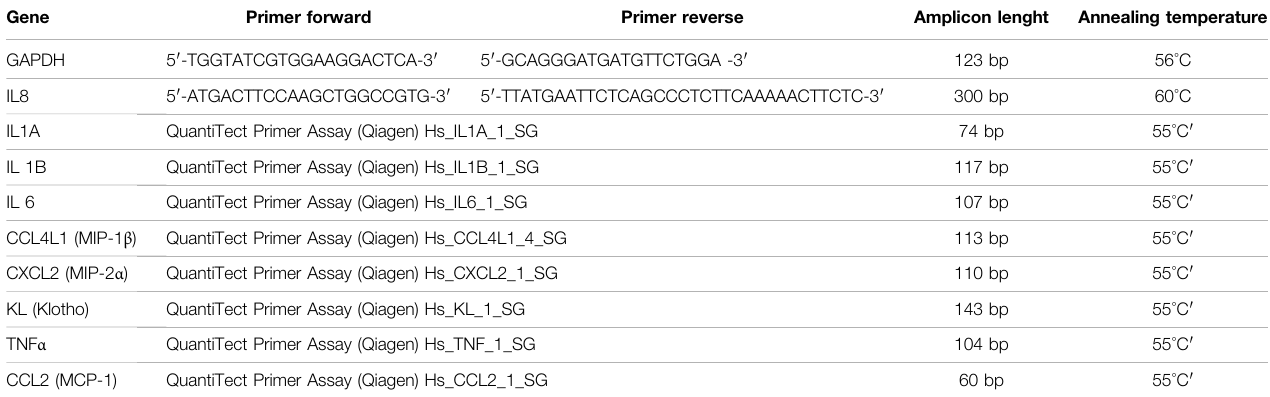
TABLE 2 | Primer details for the senescence-associated